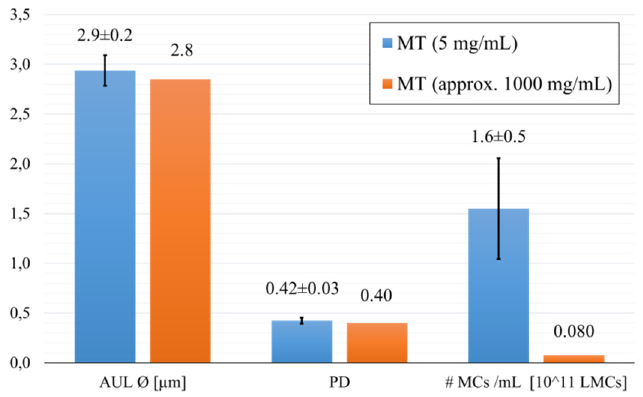
Figure 4. Graphical comparison of the results obtained for different MT concentrations in the MT_SLS-MC MT_SLS-MC system.